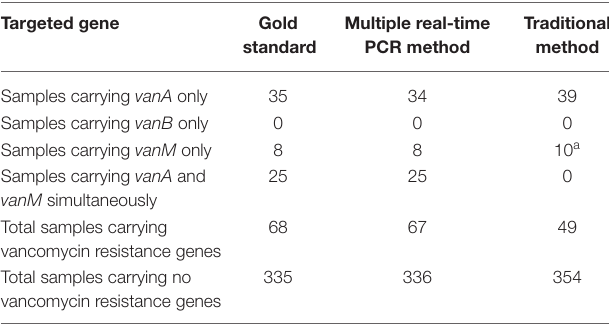
TABLE 1 | The results obtained by using three methods to detect vanA , vanB , and vanM in 403 c1linical rectal swabs after analysis of discordant results. Targeted